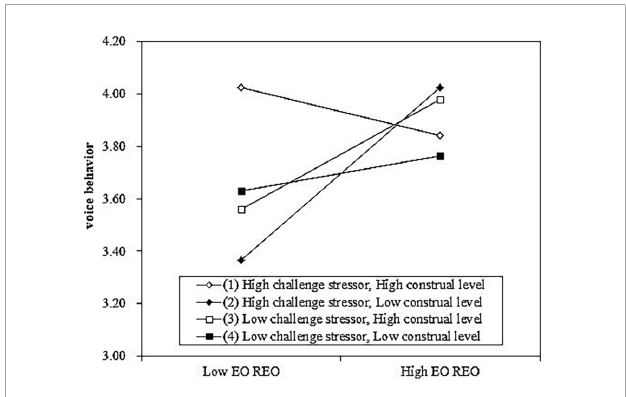
FIGURE1 Results of the three-way interaction in study 1 [employees-organization reciprocal exchange orientation (EO REO) represents employees-organization reciprocal exchange